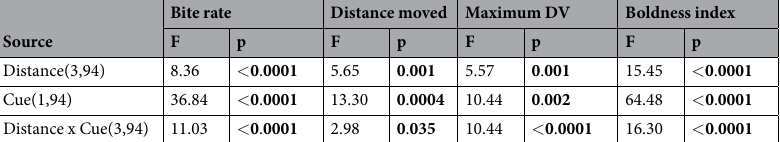
Table 1. Comparison of four behavioural traits of juvenile Ambon damselfish placed on patches of live coral positioned at four distances (0.1, 0.5, 2 and 5 m) from banks of dead-degraded coral and exposed to one of two olfactory cues (seawater, alarm odour). Results are from ANOVA’s on individual